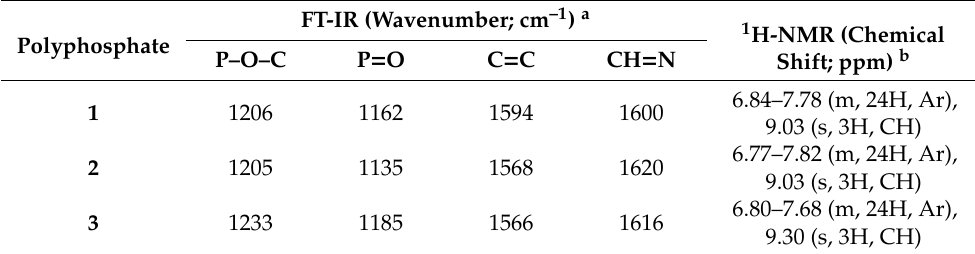
Table 2. FT-IR and 1 H NMR spectral data for 1–3 .